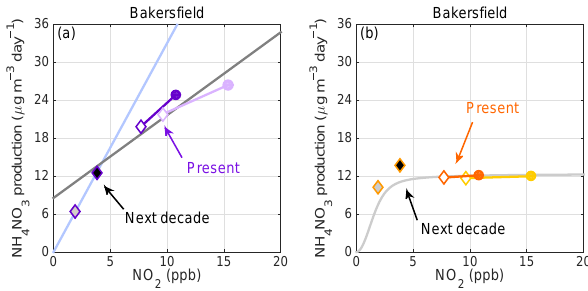
Figure 8. In Bakersfield: tethered 3-year weekday (closed circles) and weekend (open diamonds) medians of calculated wintertime NH 4 NO 3 production (µgm − 3 day − 1 ) in the NRL (a) and during the daytime (b) versus NO 2 . Medians and means give the same re- sult. Brighter data are observationally constrained 3-year medians at present (2010–2013). Pale points are observationally constrained 3-year medians at the start of the record (2001–2004). Predicted NH 4 NO 3 production at − 50% weekend NO x are black-filled dia- monds and − 75% weekend NO x are gray-filled diamonds. Week- end data were selected simply to expand the NO x range of indi- vidual curves; impacts on weekdays can be inferred. In panel (a) , the light blue line is stoichiometric and the gray line is a fit to the annual observations as in Fig. 5. In panel (b) , the gray line is the cal- culated HNO 3 production with P HO x and organic reactivity equal to present-day